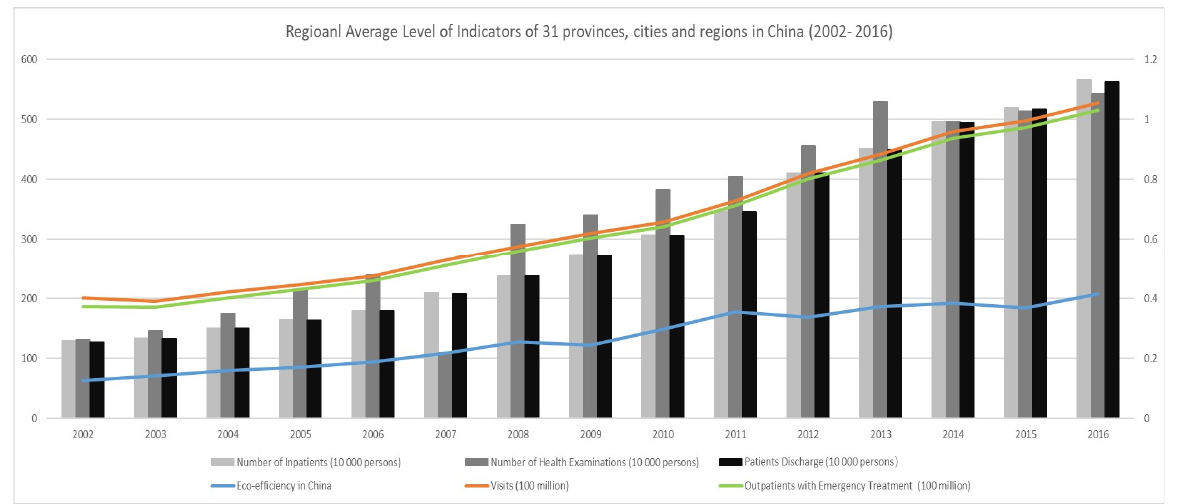
Figure 2. Regional average level of the used indicators in China.